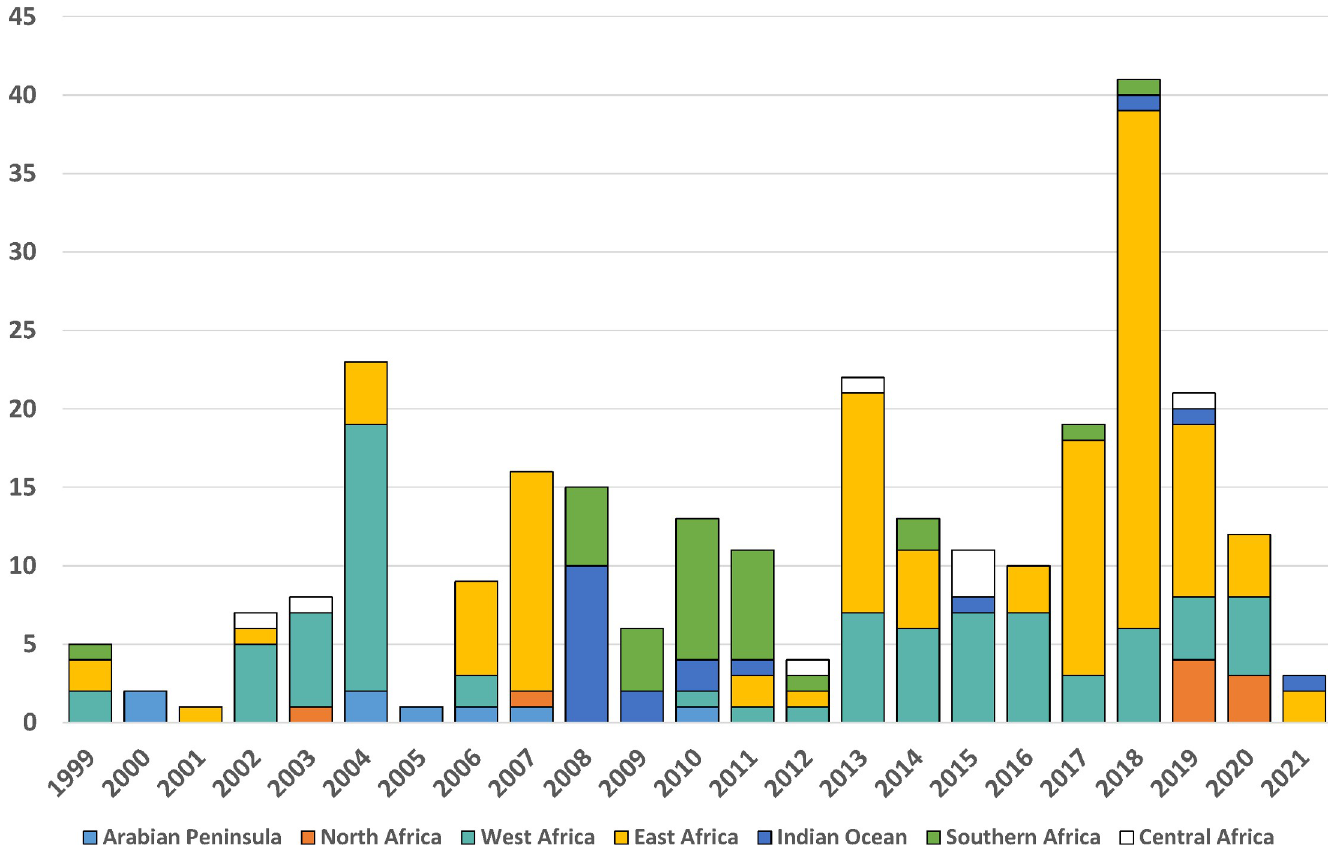
Fig 6. Acute animal RVF events per year during 1999–2021, by geographic regions across Africa, the Indian Ocean, and the Arabian Peninsula.